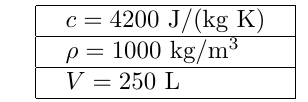
Table 9: Assumed known parameters of reactor tem- perature